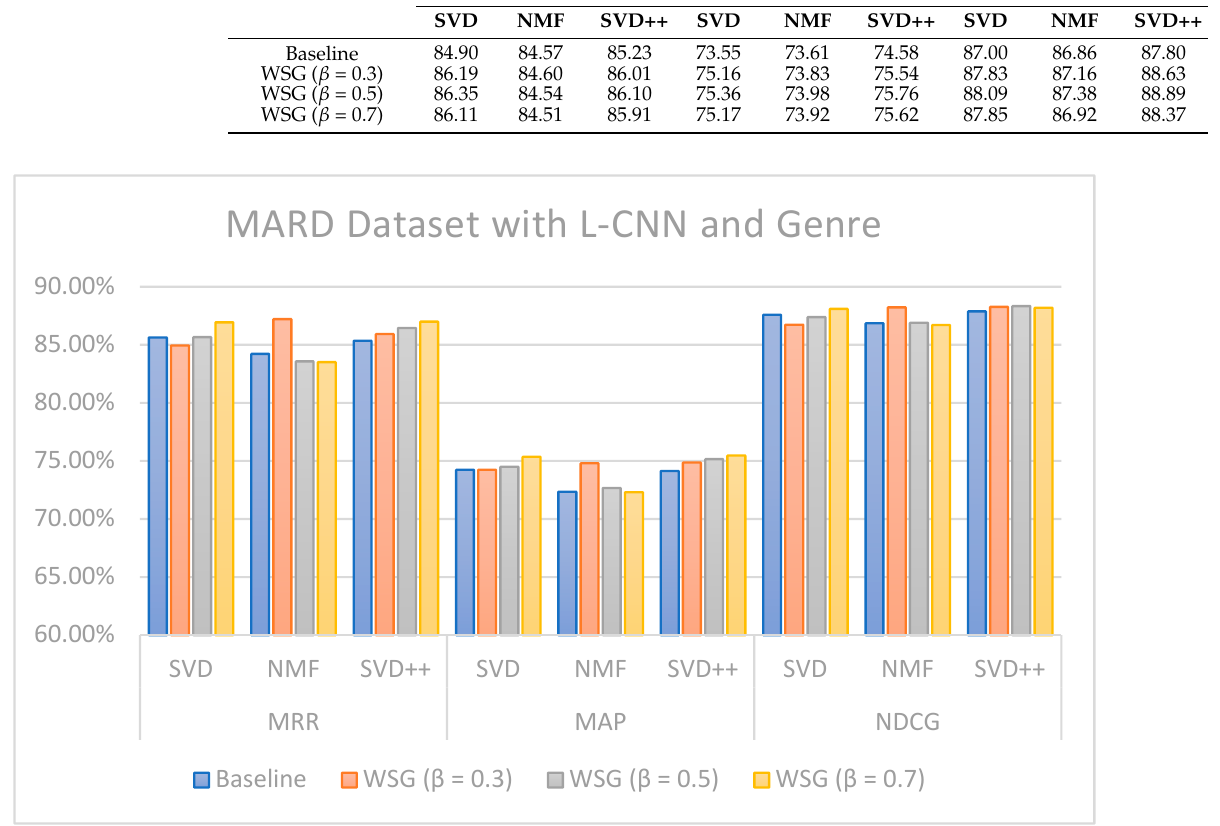
Figure 4. MRR (Mean Reciprocal Rank), MAP (Mean Average Precision), and NDCG (Normalized Discounted Cumulative Gain) values without and with L-CNN (Long Short-Term Memory-Convolutional Neural Networks) sentiment and genres-based model on the MARD dataset with different β values.